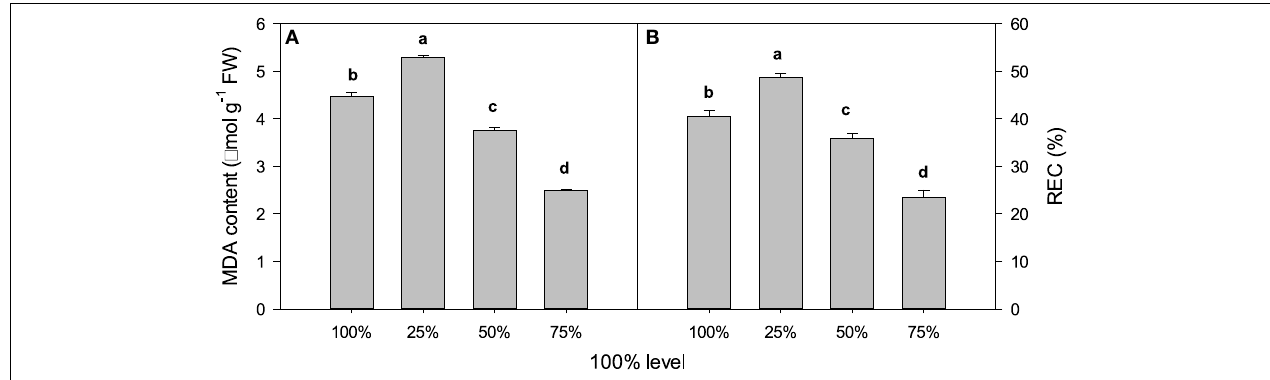
FIGURE 3 | Light intensity and (A) MDA content and (B) relative electrical conductivity (REC) in C. acuminata leaves. The values presented are the means ± SE . Different letters indicate significant differences between irradiance treatments ( P < 0 . 05 ); n = 5 . 100% level = 1500 ± 30 µ mol m − 2 s − 1 .